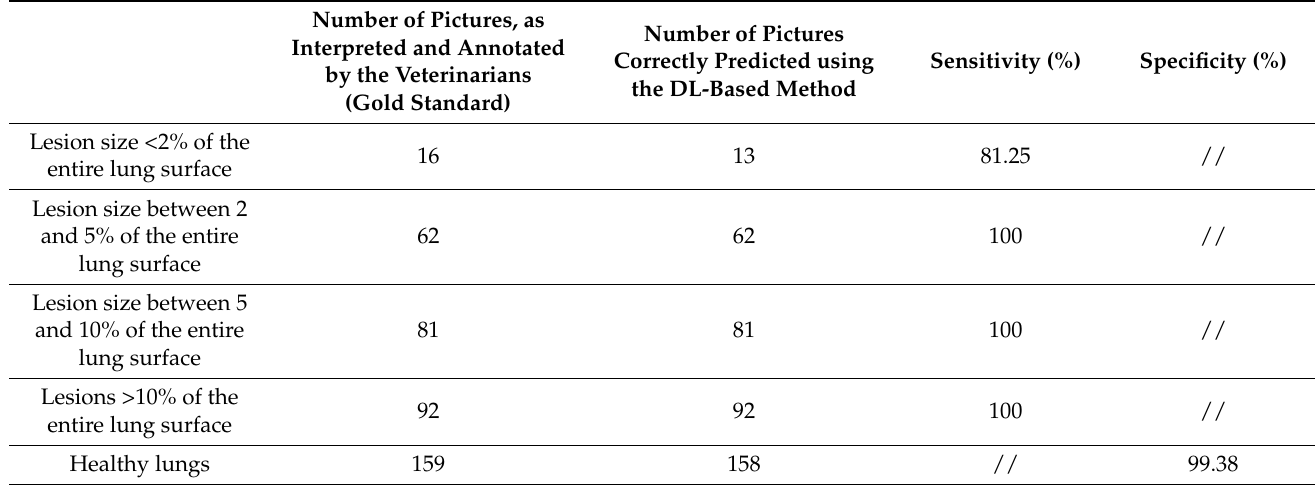
Table 1. Sensitivity and specificity of the DL-based method on the test set.